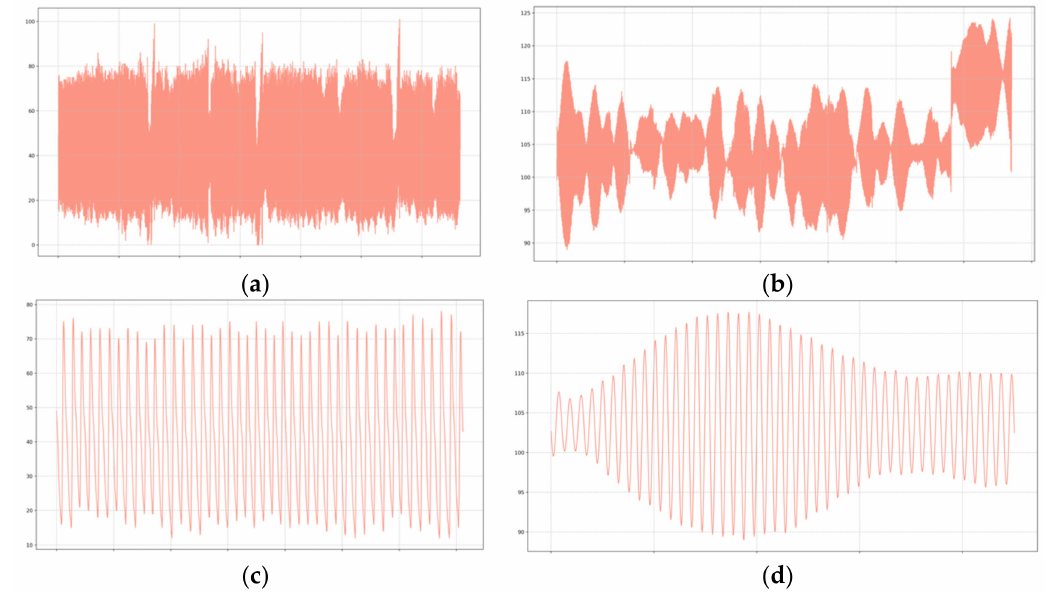
Figure 3. ( a ) Raw PPG signal; ( b ) red channel of the color-augmented video signal; ( c ) half-minute interval of the raw PPG signal; ( d ) half-minute interval of the color-augmented video signal.